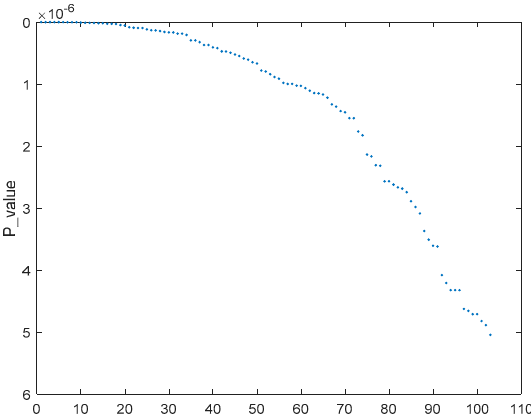
Figure 4. p -value corresponding to the 103 selected genes.